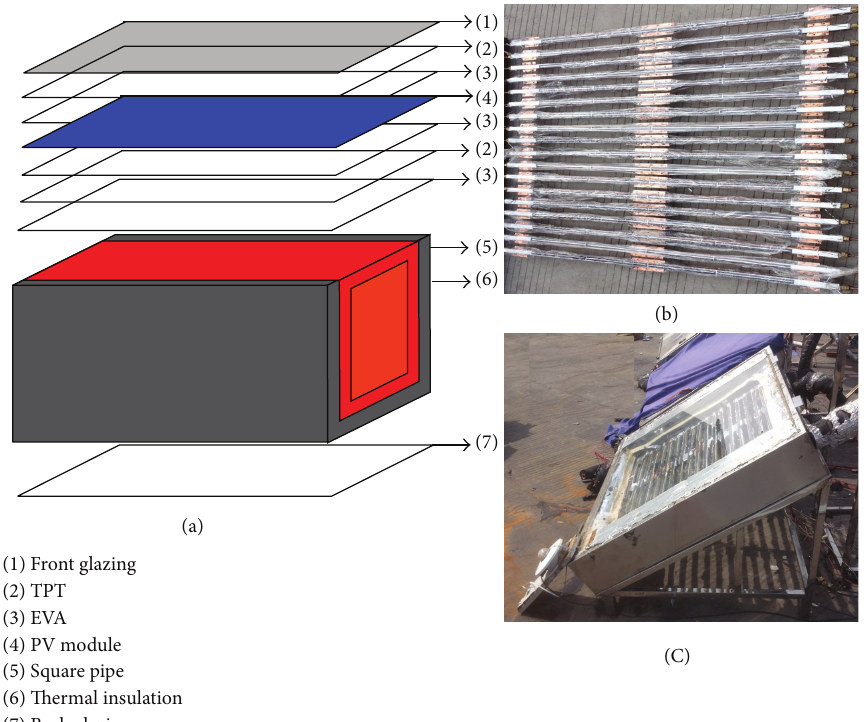
Figure 2: SPV/T structure: (a) constituent layers of PV/T, (b) PV/T, and (c) photo of SPV/T solar collector.